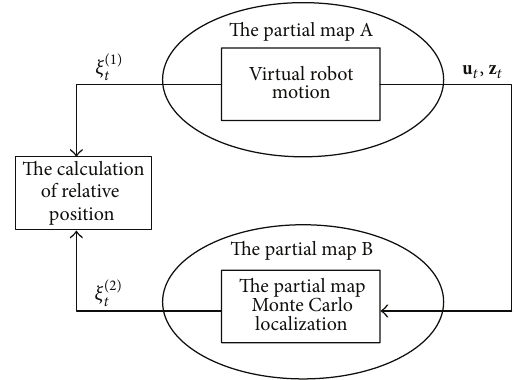
Figure4:Calculationofrelativeposeofmapsbasedonvirtualrobot motion.